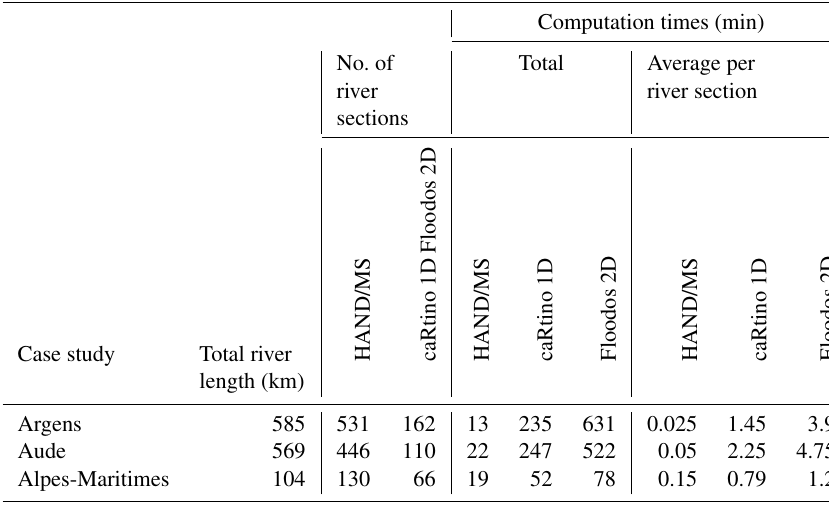
Table 1. Comparison of computation